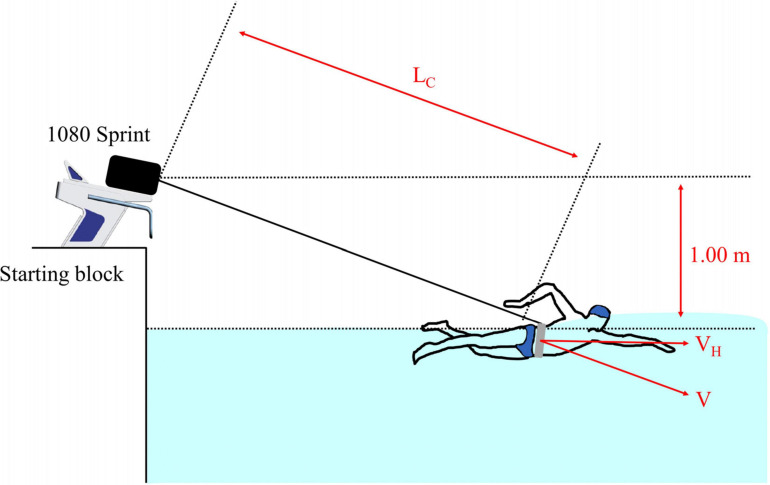
Testing setting for semi-tethered swimming trials. LC, V, and VH show the length of the cord, velocity measured by the machine, and the horizontal component of the measured velocity, respectively.